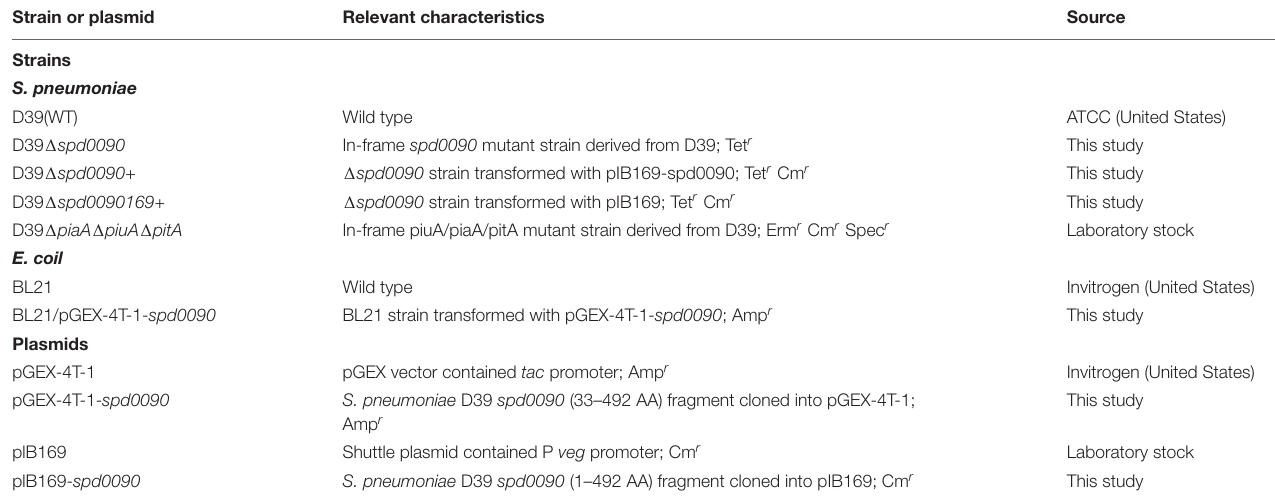
TABLE 1 | Strains and plasmids used in this study.